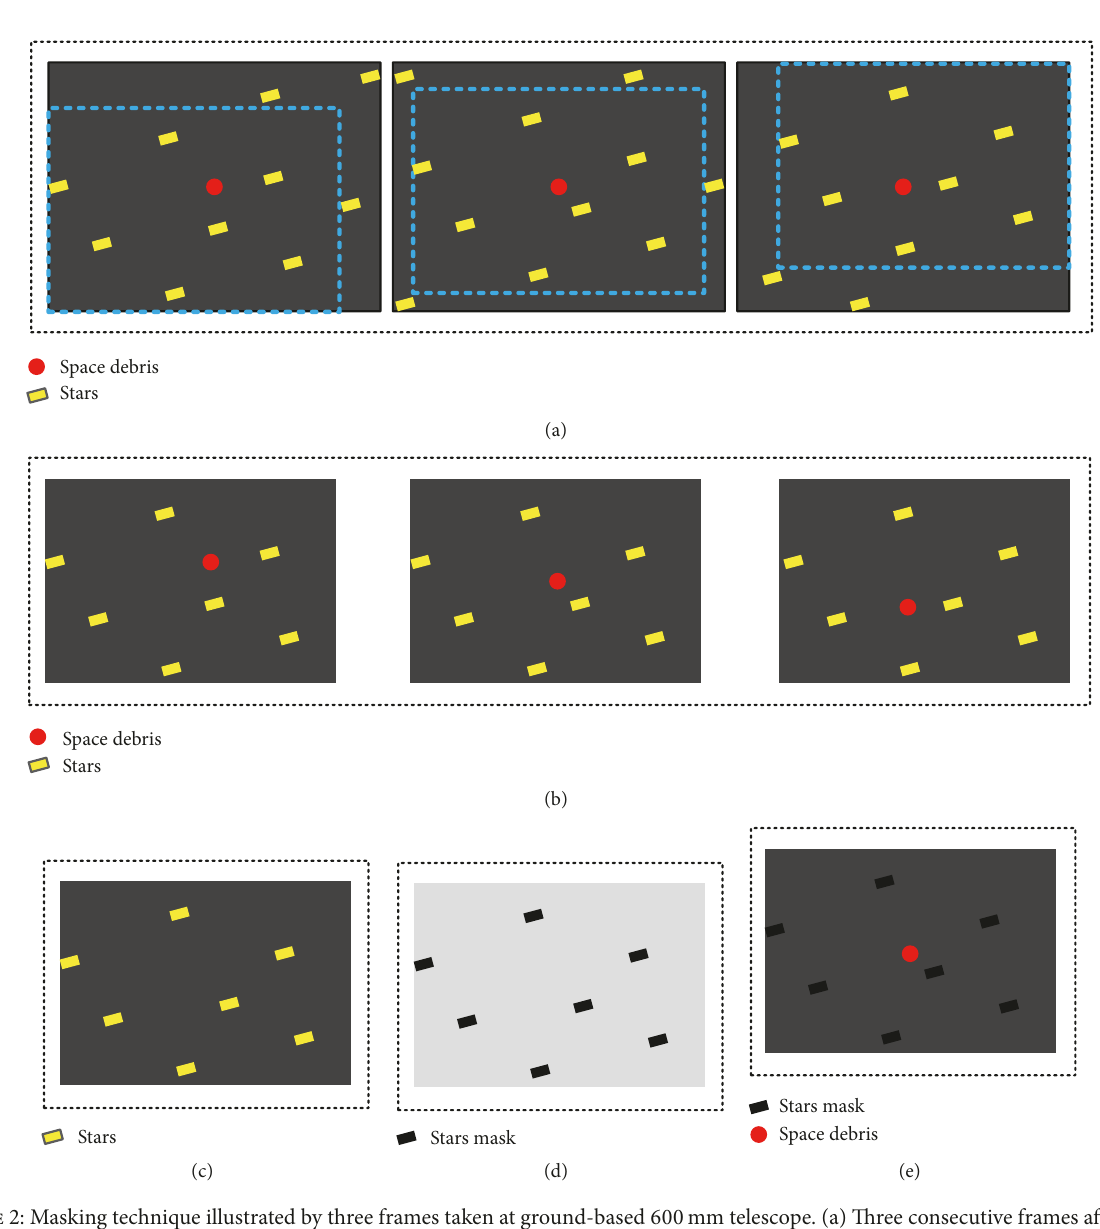
Figure 2: Masking technique illustrated by three frames taken at ground-based 600 mm telescope. (a) Three consecutive frames after image processing. (b) Image panning from (a). (c) The median frame of (b). (d) The mask image generated from (c). (e) An object is visible on the masked search frame. The frames are 1/100 part of the real frames taken by